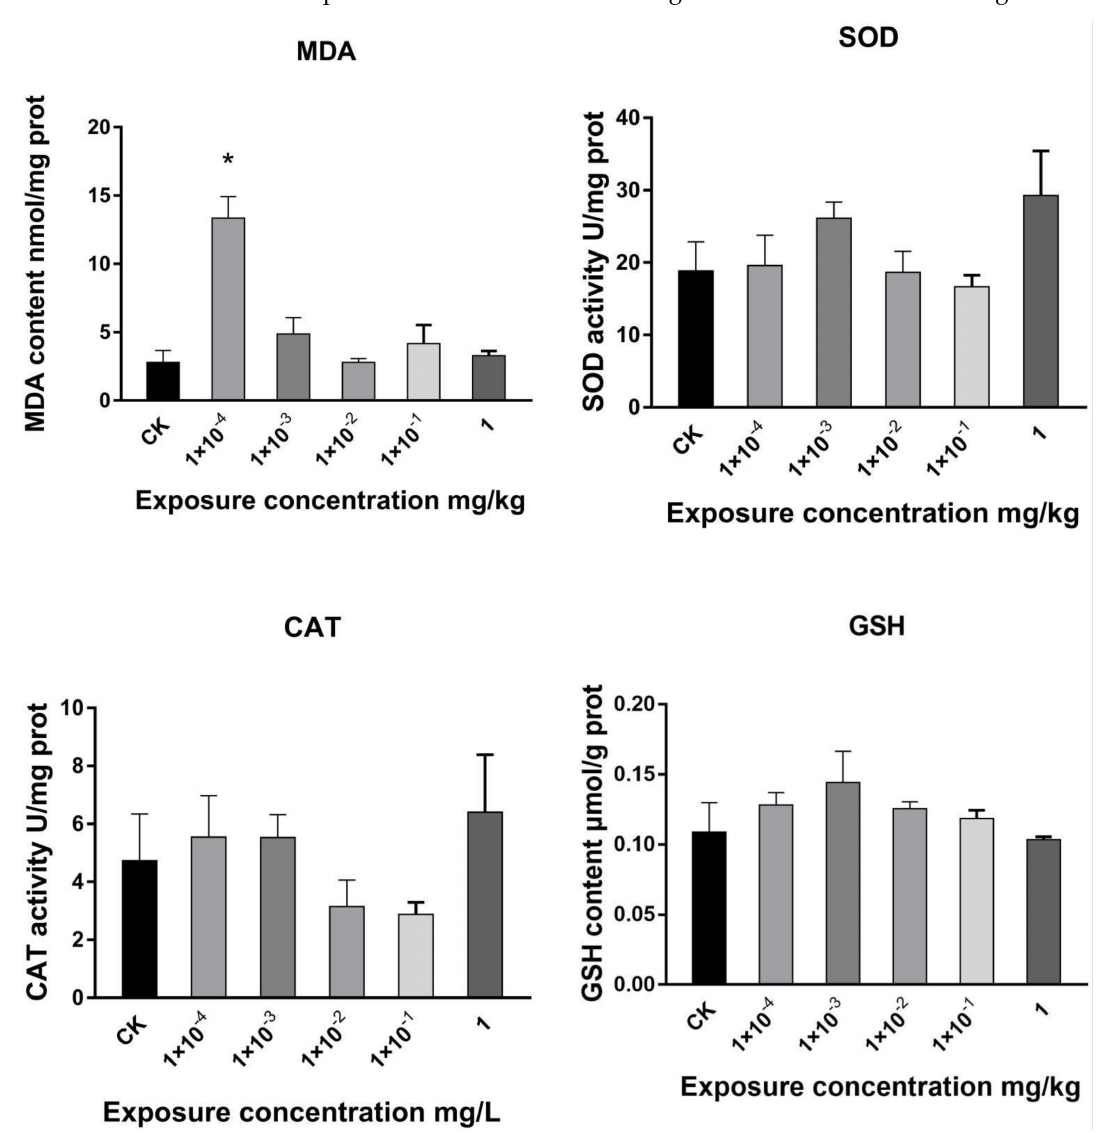
Figure 1. Changes in MDA, SOD, CAT, and GSH in Tubifex after exposure to Dufulin at different concentrations for 7 days. Each data set is represented as the mean value of three samples. Error bars indicate standard deviation (SD). (*: p <